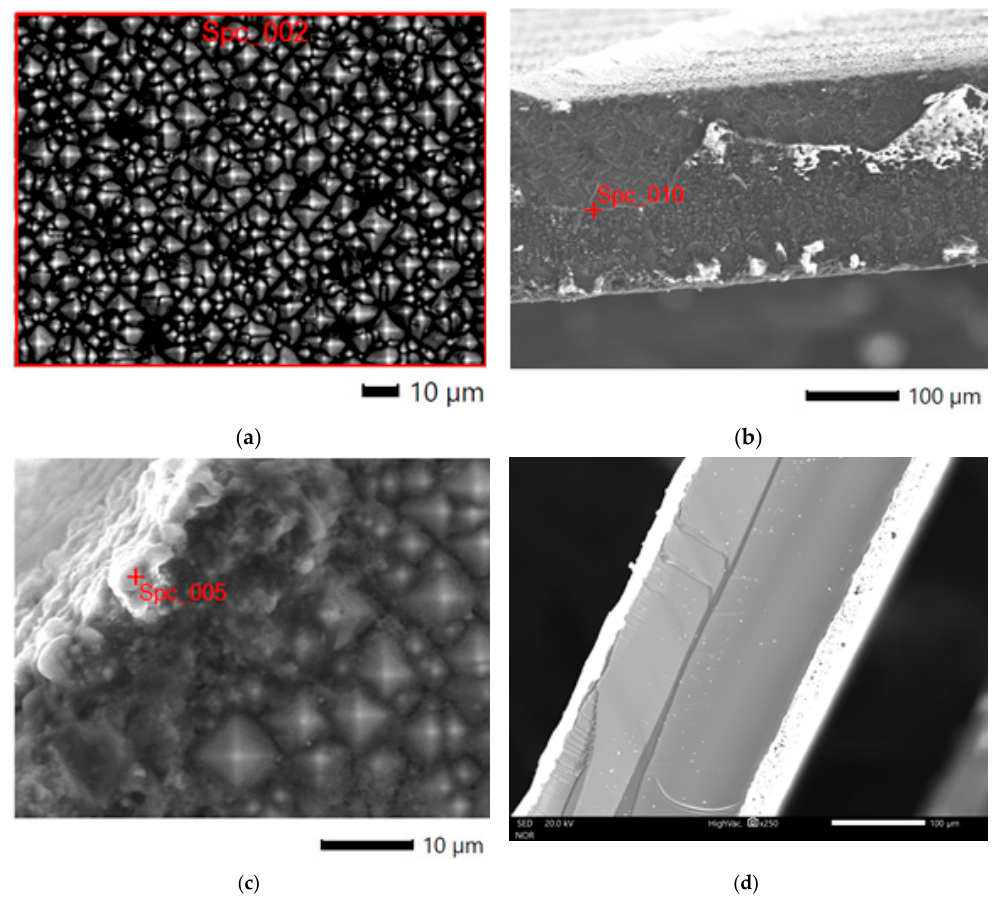
Figure 5. SEM pictures of the surface of a monocrystalline photovoltaic cell ( a ) surface without laser modification (1000× magnification), ( b ) the point on the surface of the cutting line cross-section of the tested sample (250× magnification), ( c ) the point on the cell surface next to the cutting edge (magnification 2500×), and ( d ) the surface of the fracture (250× magnification).